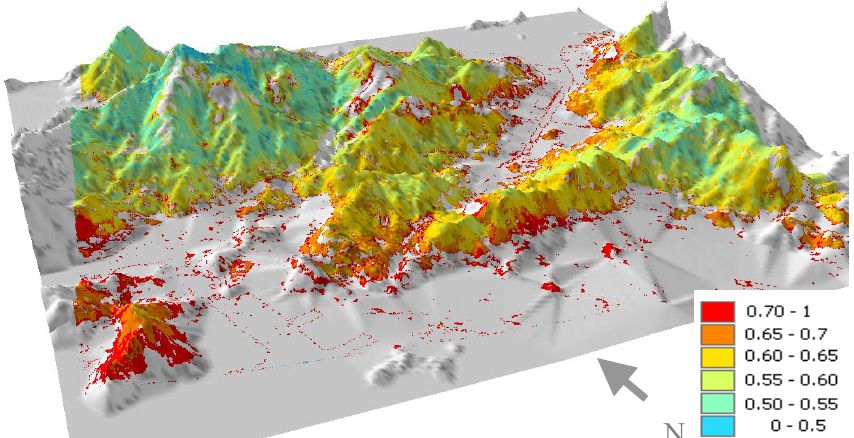
Figure 7 . Classified AOT image draped over DEM of CHRIS image area looking NNE, from the flat, urbanized Kowloon Peninsula over the mountainous New Territories, with the small urban centres of Shatin at top right and Tsuen Wan at centre left. NB. Urban areas have no AOT values